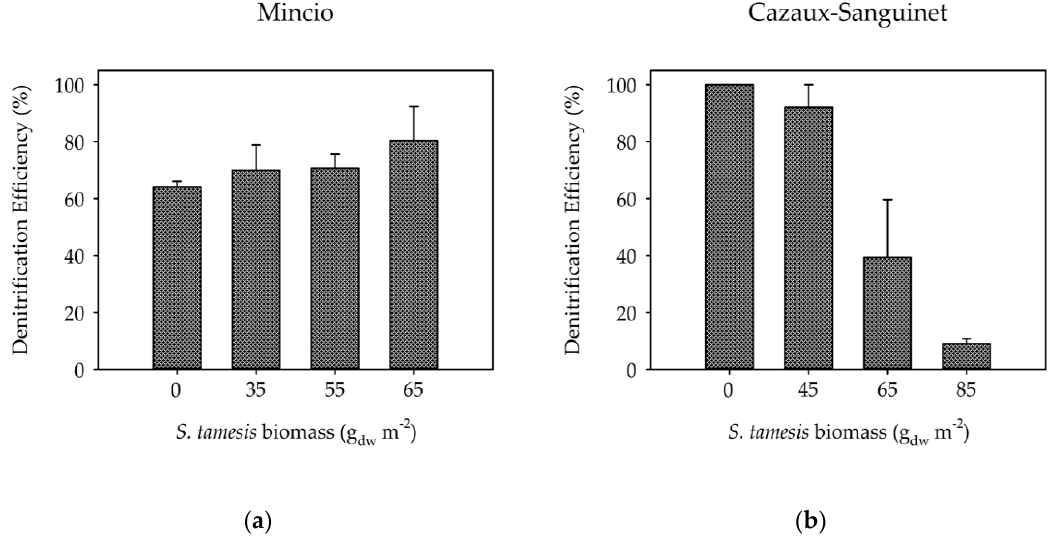
Figure 5. Denitrification efficiency (%) calculated in the 4 treatments of ( a ) the Mincio River and of ( b ) the Cazaux-Sanguinet Lake. Averages ± standard errors are reported.